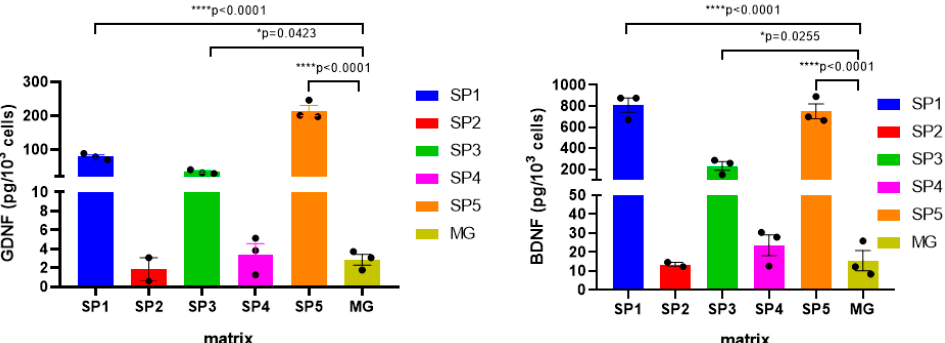
Figure 9. Effect of cell cultivation on the CCs on the levels of NTFs in the DNs (measured by ELISA). Individual repeat values in the histogram are indicated by black dots. Mean ± SEM, N = 3. One-way ANOVA followed by Dunnett’s post hoc test. * p ≤ 0.05, **** p ≤ 0.0001 versus